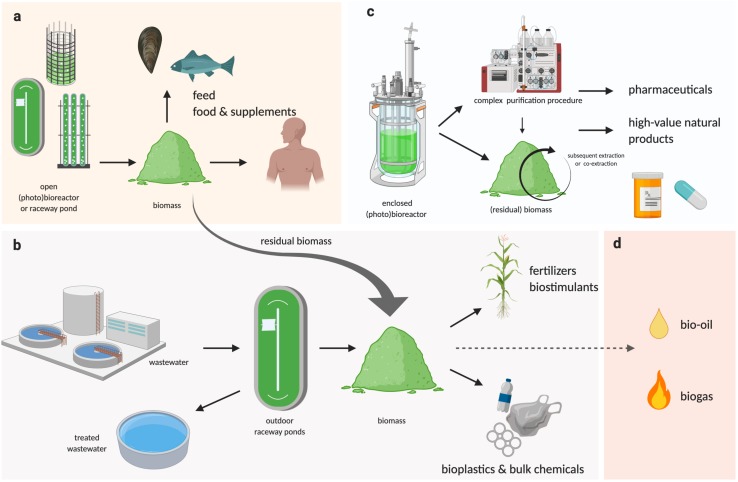
Schematic representation of a multi-product algal bio-refinery model. (a) Algal biomass cultivated at large scale in outdoor raceway ponds or large PBRs can be used as feed or food supplements, where the residual biomass and/or biomass generated from bioremediation processes can be used for industrial applications (b), as well as for bioenergy (d, not reviewed here), while pharmaceuticals or other high-value products requiring complex and controlled extraction procedures could be co-extracted or subsequently extracted from algal biomass grown in enclosed bioreactors (BRs) or photobioreactors (PBRs) (c).